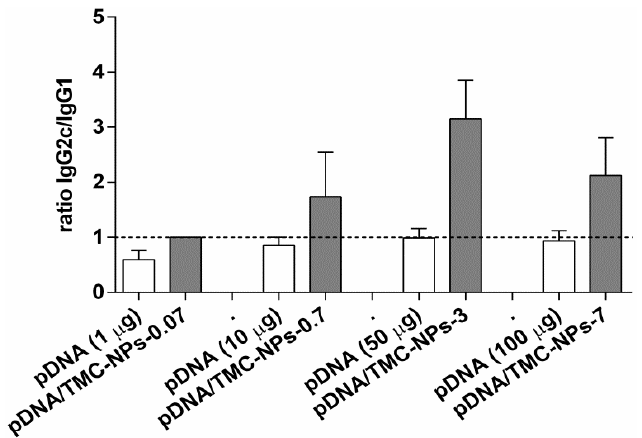
Figure 3. Influence of different pDNA doses on Th1 and Th2 polarization, either alone or adsorbed to TMC nanoparticles. Mice were immunized three times at three-week intervals, and sera were analyzed by ELISA at Week 7. Bars represent the mean ( n = 5) ± SEM. The ratios of IgG2c and IgG1 antibodies specific to Ag85A were determined, and values higher than one (dotted line) characterize Th1-biased immune responses.